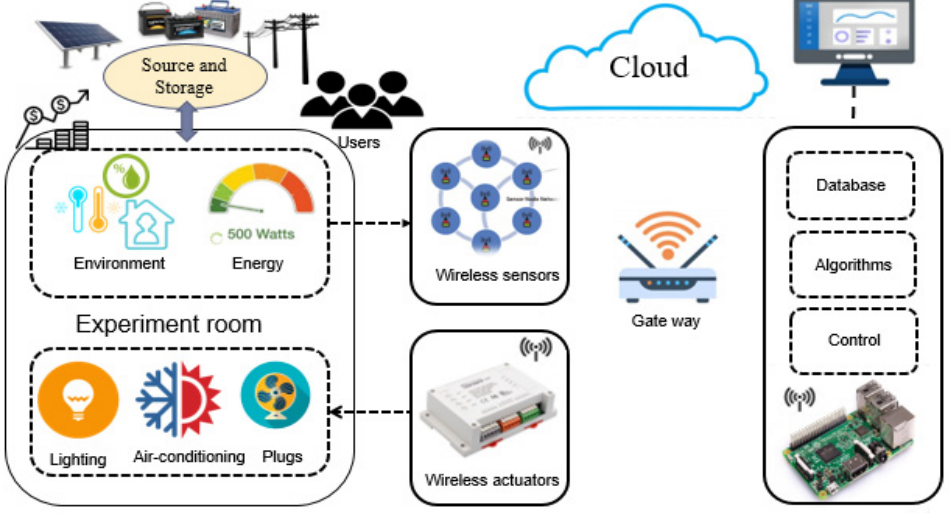
Figure 1. Schematic of a building monitoring platform [26].